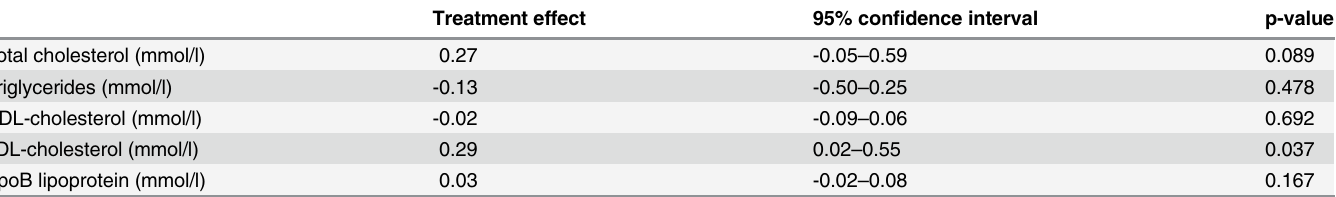
Table 3. The absolute changes in lipid levels during treatment with Danshen, corrected for the changes during treatment with placebo. CROS anal- ysis according to Senn (see statistical section for explanation). A negative number indicates a decrease by Danshen.